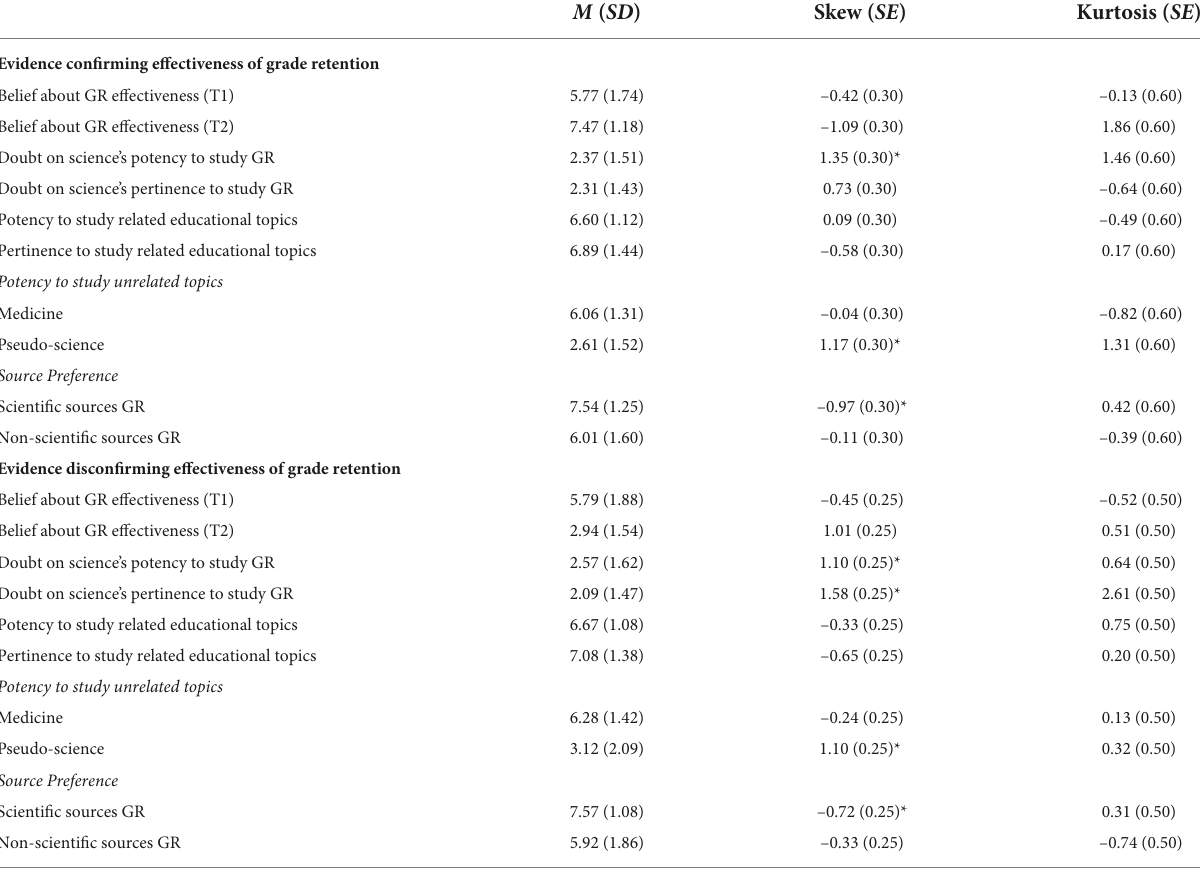
TABLE 2 Study 2: Descriptive statistics by evidence